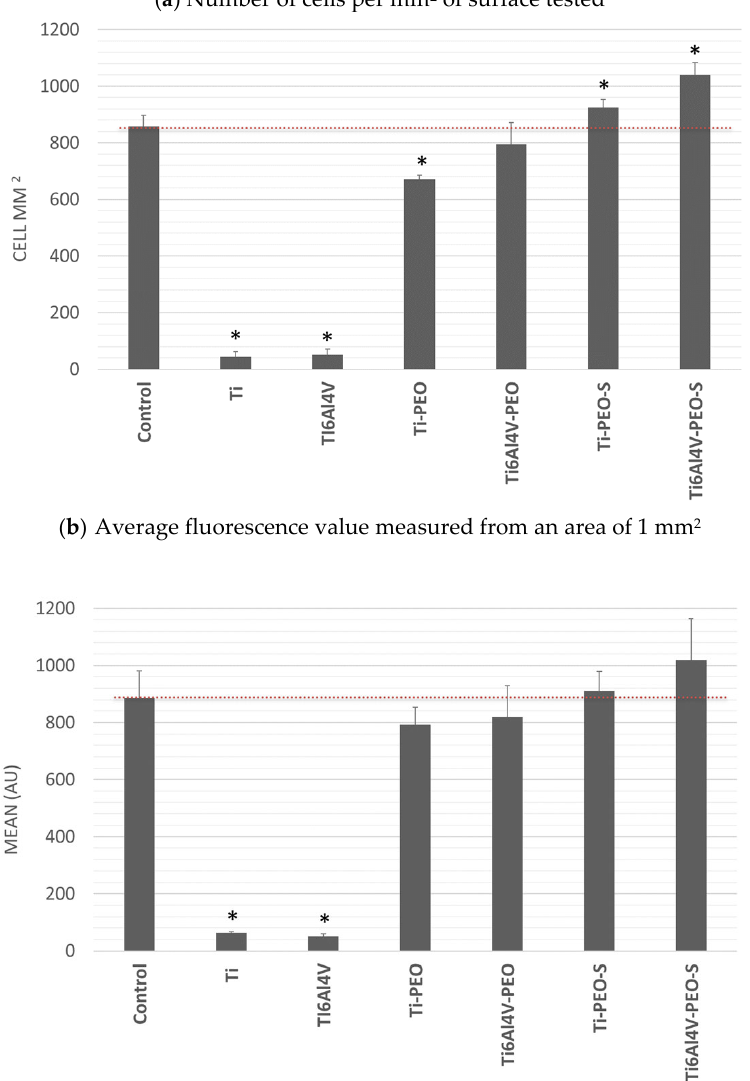
Figure 5. Adhesion and proliferation of NHDF on test surfaces modified after 72 h: ( a ) number of cells per mm 2 of test surface, ( b ) mean fluorescence value measured from an area of 1 mm 2 . * Statistically significant difference ( p < 0.05) compared with control.